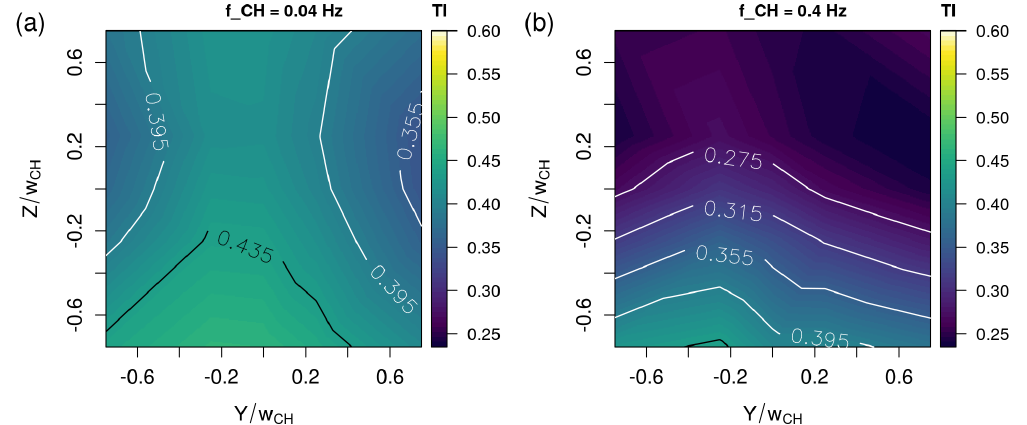
Figure 9. Interpolated surface plot of the turbulence intensity of the inverse gust for (a) f CH dashed line marks the downstream position of the YZ plane.